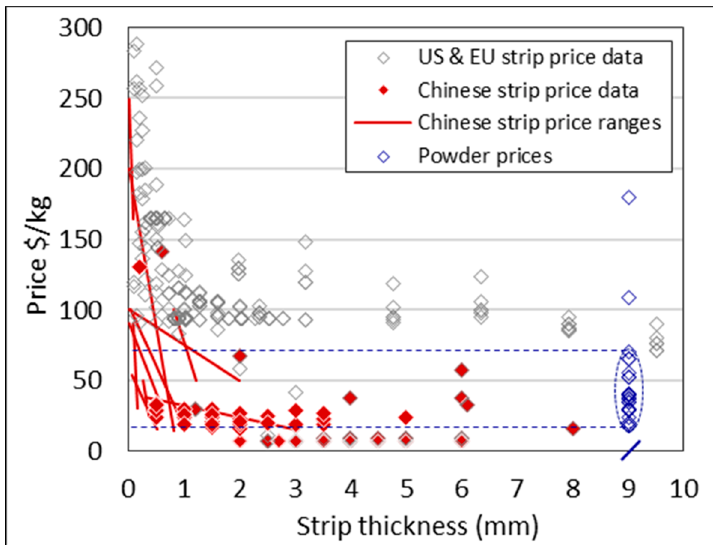
Figure 17. Price of wrought strips from China and the US and EU versus the price of titanium powder (powder prices indicated at/mark on x-axis). The straight red lines indicate a range.